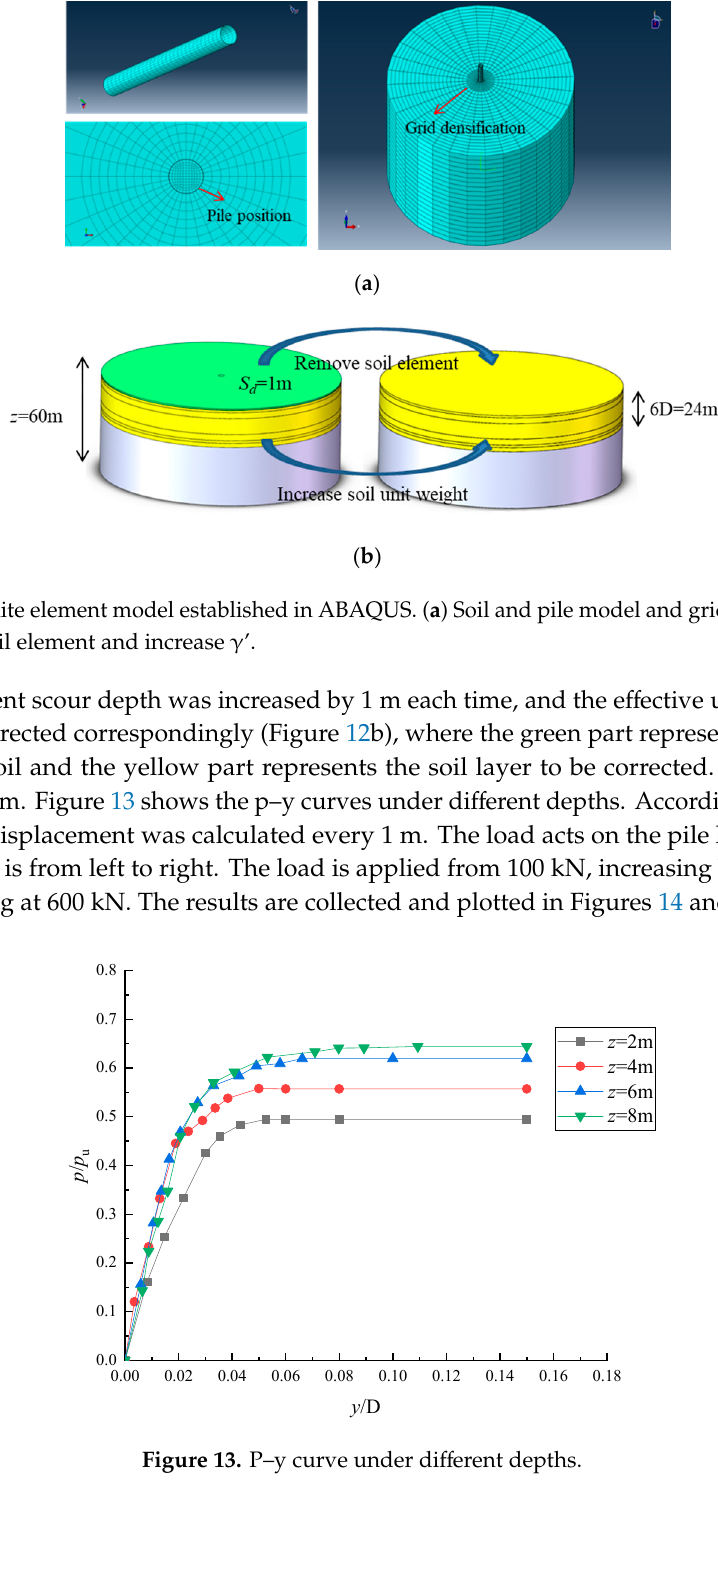
( b ) Figure 14. Pile head displacement of monopile under scour. ( a ) Scour depth–displacement under different load levels; ( b ) load–displacement under different scour depths. Figure 15. Scour depth–apparent fixity depth under different load levels. 4.2. Discussion